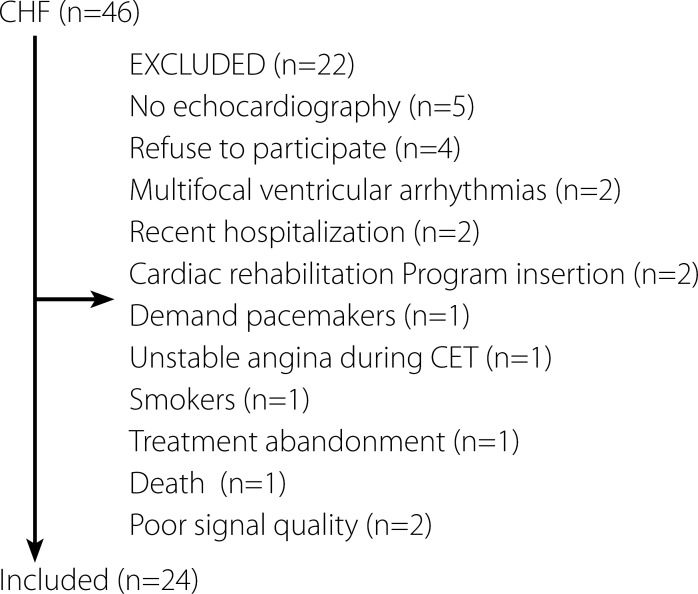
Flowchart of the present study. CHF = chronic heart failure; CET =
cardiopulmonary exercise test.